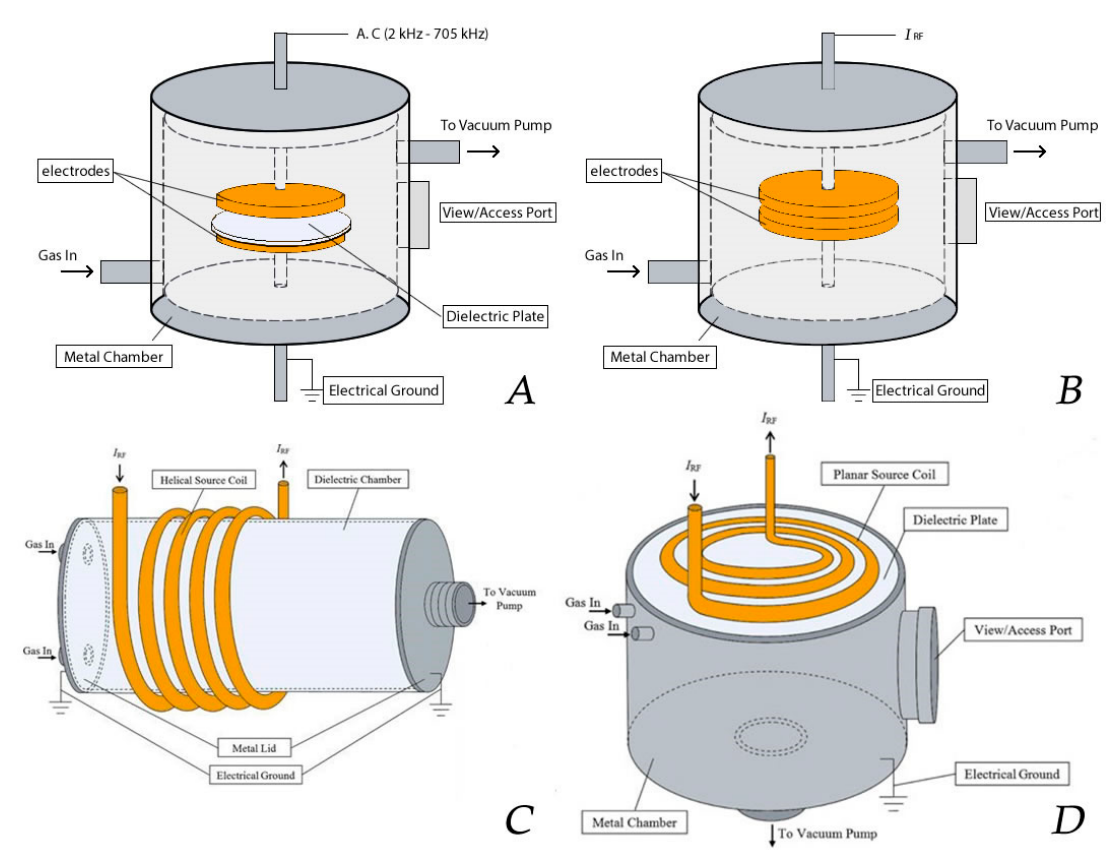
Figure 13. Typical plasma reactor set-ups of ( A ) a dielectric barrier discharges (DBD), ( B ) a capacitively coupled plasma (CCP) and ( C ) an inductively coupled plasma (ICP) with helical coil configuration and ( D ) an ICP with planar coil configuration—reproduced with permission from [230]. Copyright Springer, 2017. Table 6. Comparison of various plasma set-ups.